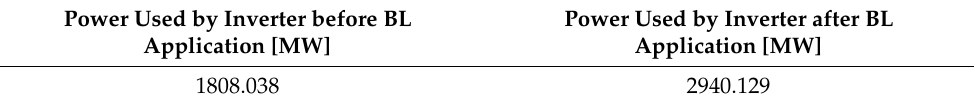
Table 3. Comparison of energy used by inverter before and after BL method application for 200 s. Power Used by Inverter before BL